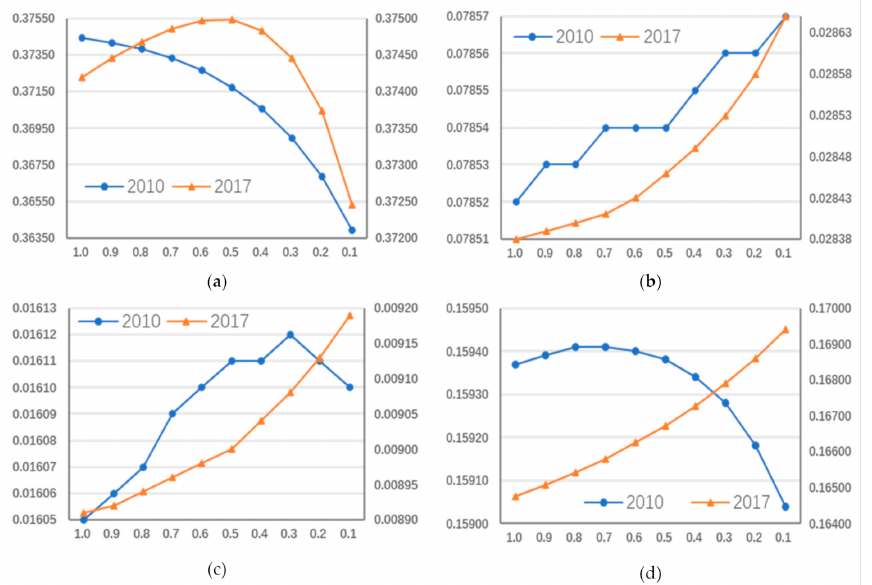
Figure 5. Coefficient changes of indicators (FAIL, PGDP, and PTS) and spatial coefficient ( γ ) under different hypothesis coefficients λ of administrative barriers in 2010 and 2017. ( a ) Shows the different spatial coefficient ( γ ) of LUI under different hypothesis coefficients λ of administrative barriers in 2010 and 2017. ( b ) Refers to the coefficient changes of FAIL under the different hypothesis coefficients λ of administrative barriers in 2010 and 2017. ( c ) Presents the coefficient changes of PGDP under the different hypothesis coefficients λ of administrative barriers in 2010 and 2017. ( d ) Indicates the coefficient changes of PTS under the different hypothesis coefficients λ of administrative barriers in 2010 and 2017. Notes: The main axis, which is on the left, represents the year of 2010 and the secondary axis, which is on the right, represents the year of